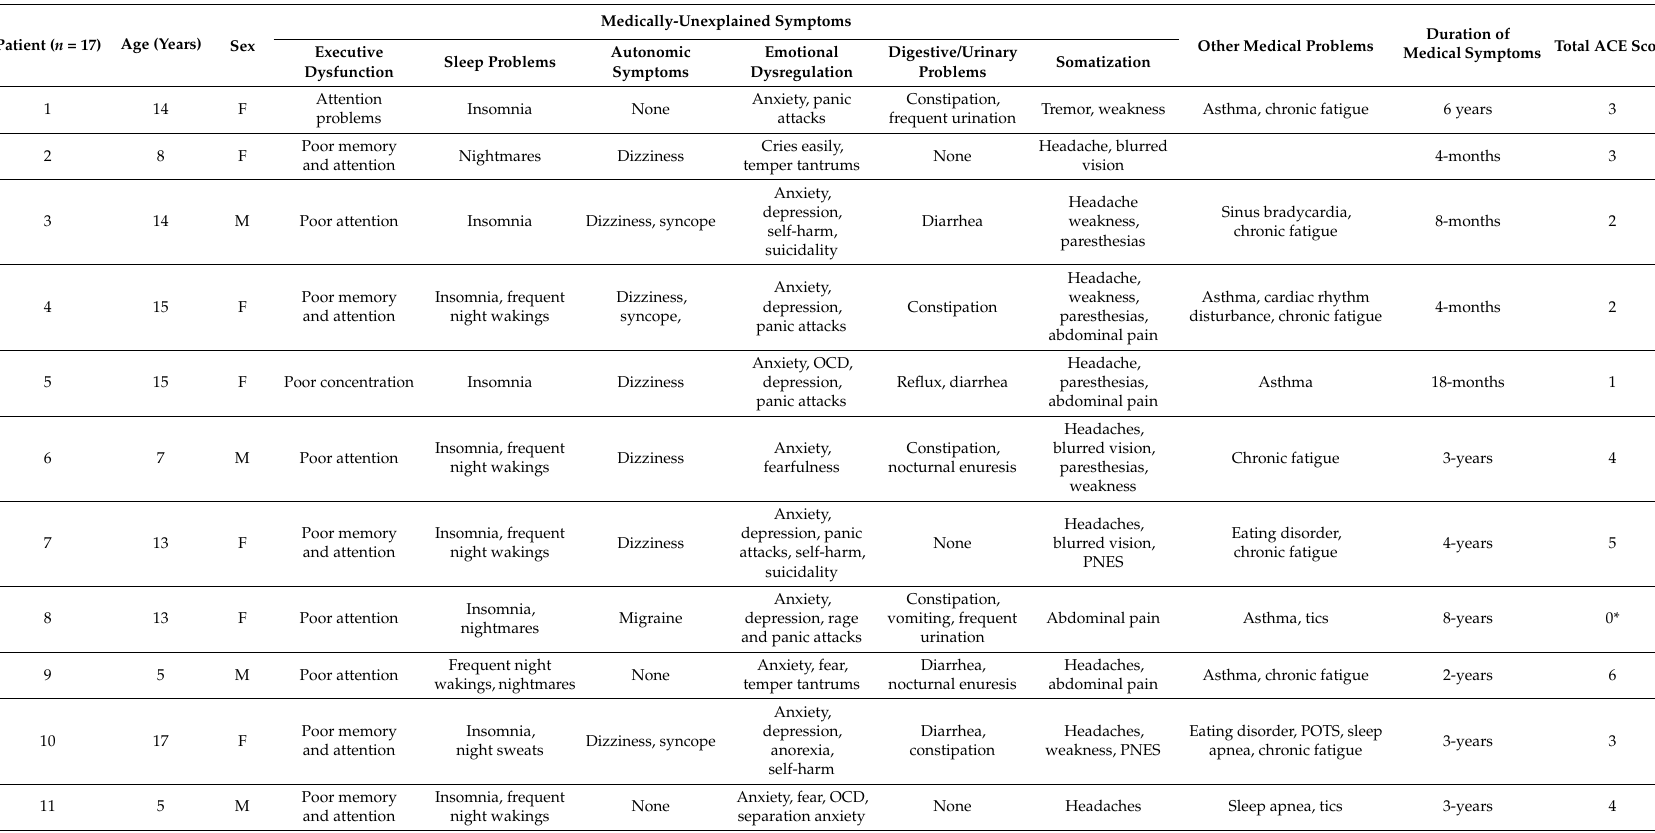
Table 1. Group A: Symptom profiles of patients with ≥ 4 medically unexplained symptoms and total adverse childhood experiences (ACE) scores.